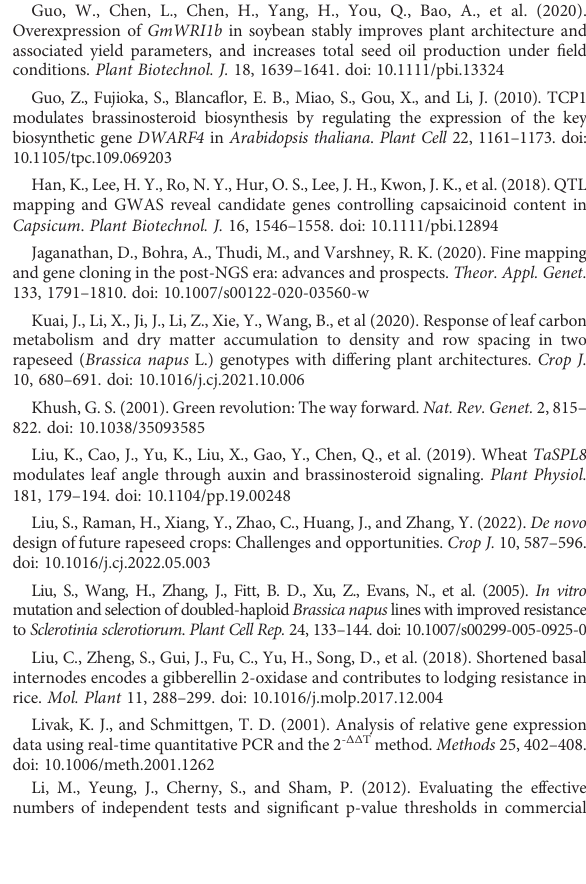
SUPPLEMENTARY FIGURE 1 Alignment of the deduced amino acid sequence between 888-5 and M083. The red rectangle represents the TCP domain. SUPPLEMENTARY FIGURE 2 Expression levels of BnaA02.TCP1 in wild-type (WT) and transgenic Arabidopsis plants (OE2, OE4, and